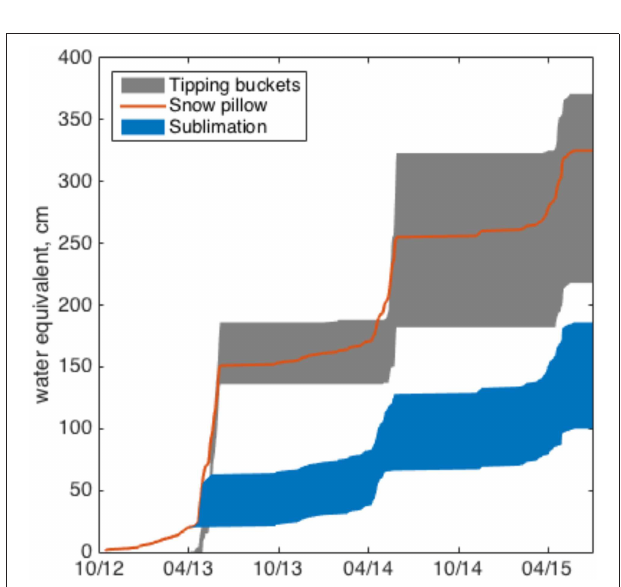
FIGURE 10 | Sublimation measured from lysimeter and snow pillow melt. The range of cumulative tipping bucket melt from three lysimeters is shown in gray. The cumulative snow pillow melt is shown in orange. Sublimation is shown in